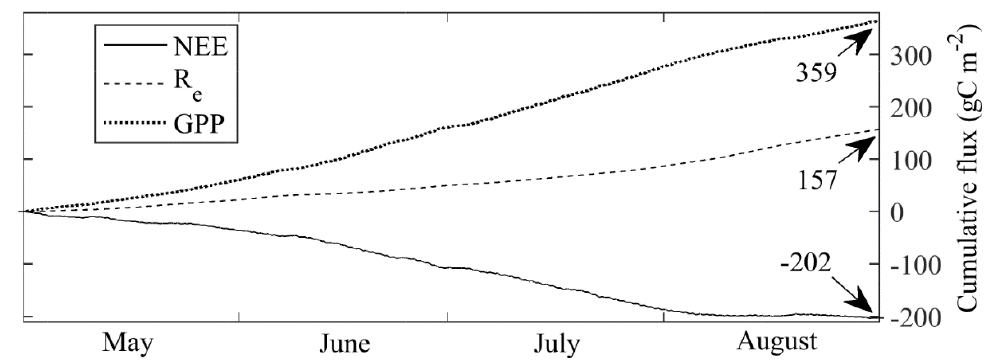
Figure 7. Cumulative gap-filled NEE, Re and GPP obtained by the eddy-covariance setup in May–August 2015. Adapted from [48].